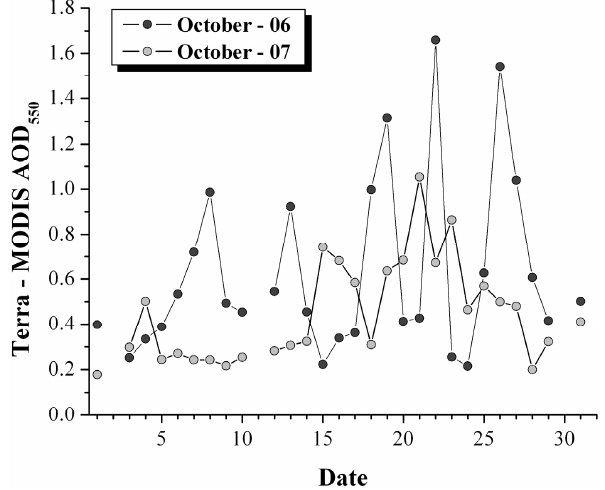
Fig. 7. Day-to-day variation of Terra MODIS AOD 500 during Oc- tober 2006 and 2007.